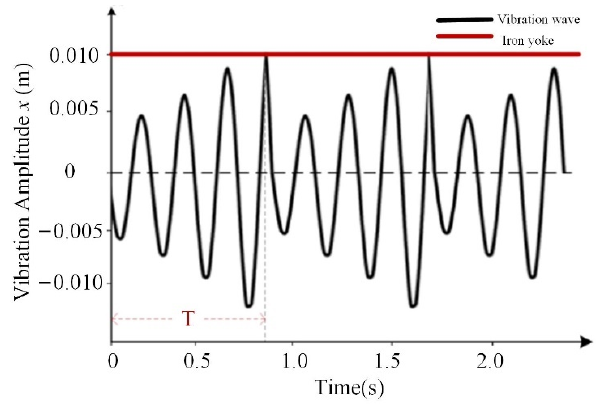
Figure 3. Law of winding vibration amplitude.